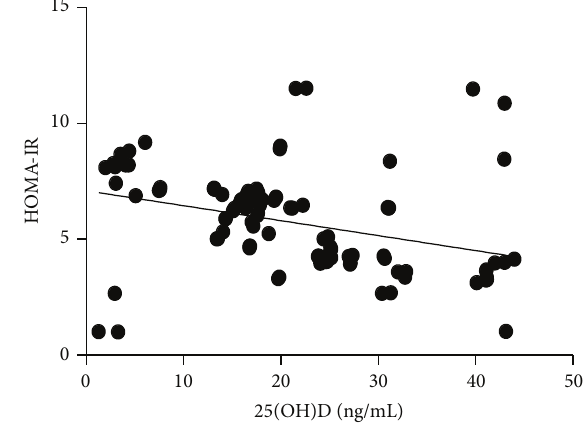
Table 4: Multiple linear regression analysis between HOMA-IR and 25(OH)D, eGFR, BMI, and age. HOMA-IR Figure 1: Inverse association between 25(OH)D and HOMA-IR 𝛽 𝑝 value (Pearson correlation = − 0.327, 𝑝 = 0.000 25(OH)D − 0.314 0.001 Age 0.077 0.446 eGFR − 0.059 0.546 BMI 0.191 0.043